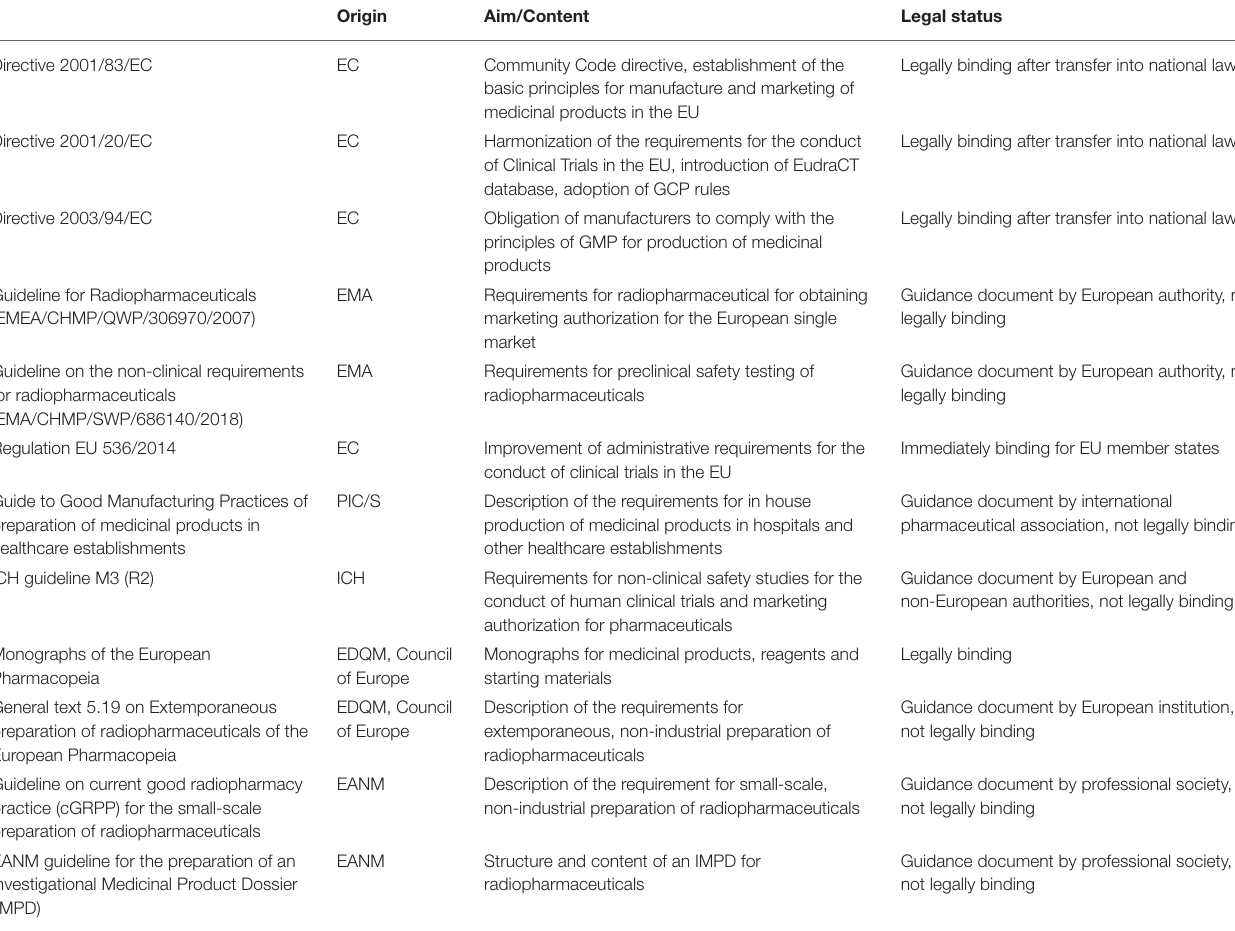
TABLE 1 | Overview of legally binding and guidance documents for